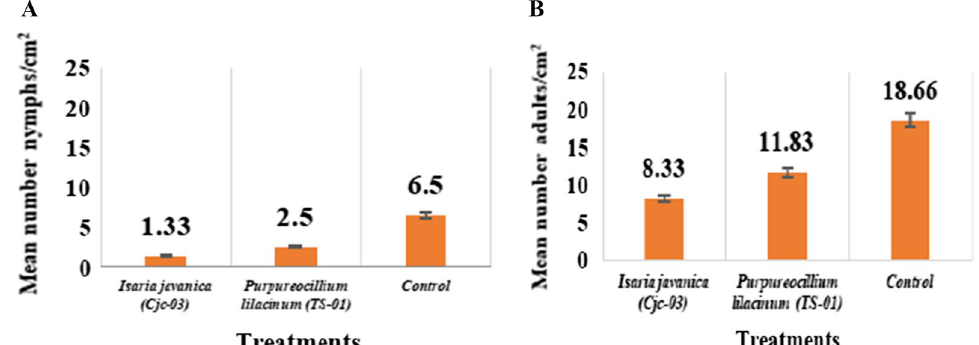
Fig. 10 Effect of Isaria javanica (Cjc-03) and Purpureocillium lilacinum (TS-01) on the mean number of nymphs and adults of Bemisia tabaci A : nymphs (III and IV) B : adult emergence of B. tabaci on tomato leaves at 42